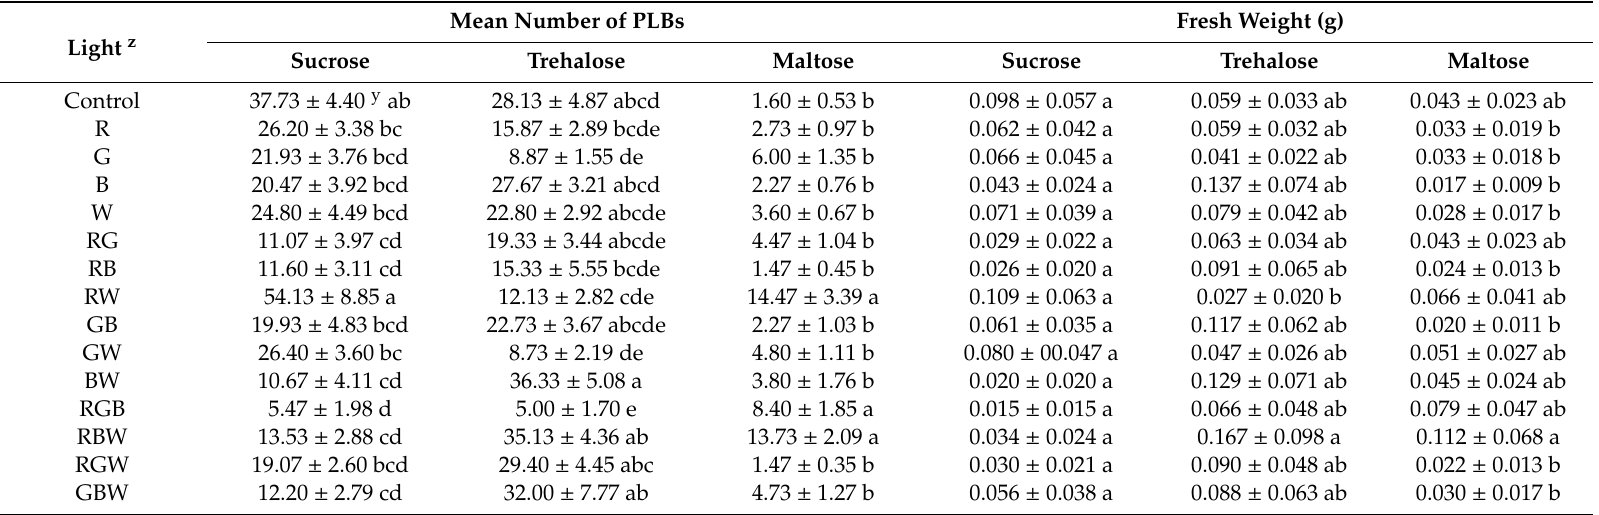
Table 1. Mean number of PLBs and fresh weight of Phalaenopsis ‘Fmk02010’withdi ff erent CHO sources and LED